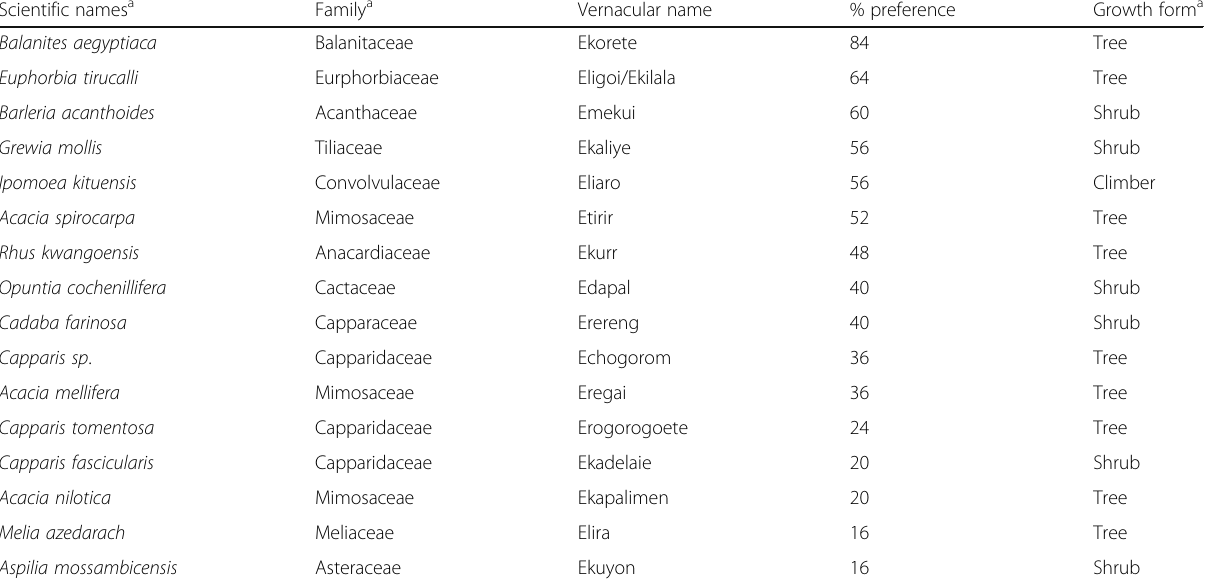
Table 4 Perceived camel forage preference in Moroto